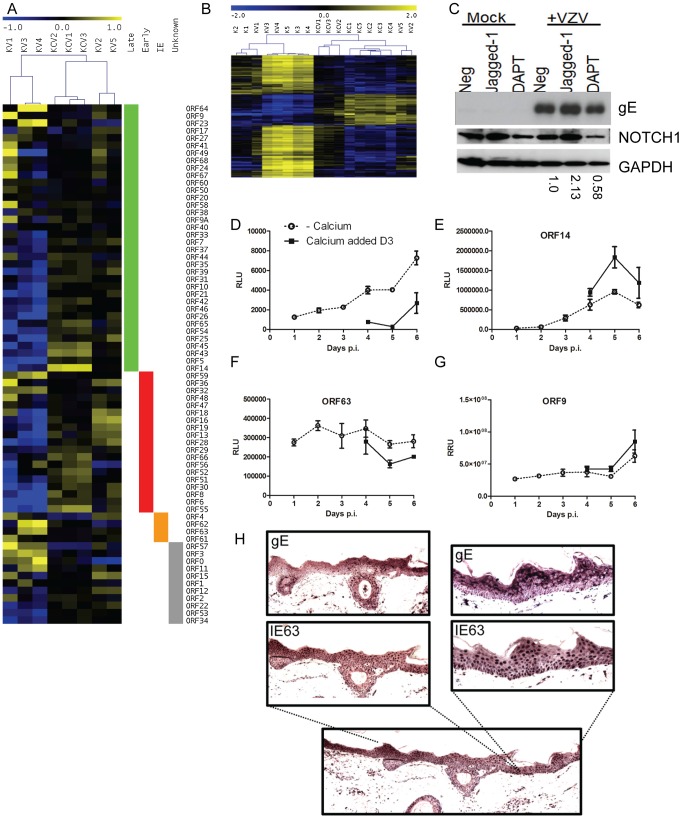
Altered VZV gene expression following keratinocyte differentiation.
A) Heatmap illustrating VZV ORF expression profiles for the infected samples. RPKM values were calculated for each sample by normalising to viral reads alone and then median-centred for each ORF to highlight relative fold changes across all samples. Samples are hierarchically clustered by Pearson's correlation coefficient. ORFs are ordered by temporal gene expression (i.e. whether they are currently categorised as late, early, immediate-early genes). Log2(fold changes) are shown relative to the median RPKM for each ORF. B) Heatmap of 1463 human genes altered solely in the KC/K comparison. TMM-normalised CPM values are median-centred for each gene to highlight relative fold changes across all samples. Genes and samples are clustered by Pearson's correlation coefficient. Log2 (fold changes) are shown relative to the median CPM for each gene. Samples cluster primarily by experimental condition (i.e. addition of calcium) with the exception of KV2 and KV5 which cluster alongside the calcium-shifted KC samples suggesting these 2 samples had undergone spontaneous contact-induced differentiation. C) Primary keratinocytes were infected VZV at an mo.i. of 0.2 and treated with either DAPT [1 µM] or Jagged-1 [50 µM] and harvested for analysis by immunoblotting 48 hrs later. Jagged-1 treatment caused an increase and DAPT treatment showed a decrease in Notch 1 expression respectively as seen in the uninfected keratinocytes. Treatment of VZV infected cells with jagged-1 increased gE expression and DAPT treatment decreased gE expression relative to the untreated VZV infected keratinocytes, the changes in gE were quantified using ImageJ and the numbers below represent the gE expression relative to the untreated VZV infected keratinocytes. Primary keratinocytes were infected with VZV at day 0 with an m.o.i. of 0.2. At day 3 half of the samples were switched to a high calcium media. Duplicate samples were taken every 24 hrs to measure luciferase and/or renilla. Three different recombinant viruses were used D) VZVLUC under the control of an IE promoter (ORF4), E) ORF14Luc and F–G) ORF63LucORF9Renilla. The average relative luciferase/renilla units RLU/RRU for each virus is plotted ± stdev. H) Skin explants were injected into the dermis with cell associated VZV (1250 PFU), placed on grids, and harvested at 3 days post infection, fixed and embedded in paraffin. Sections were stained with antibodies against the immediate early viral marker, IE63, and the late marker glycoprotein E (gE). Staining was developed with the chromogen VIP. No staining was seen in the uninfected controls (data not shown). Although epidermal infection was evident, this model did not demonstrate epidermal blistering. VZV staining is present throughout the epidermis and the expression gE was more apparent in the higher layers of the epidermis.